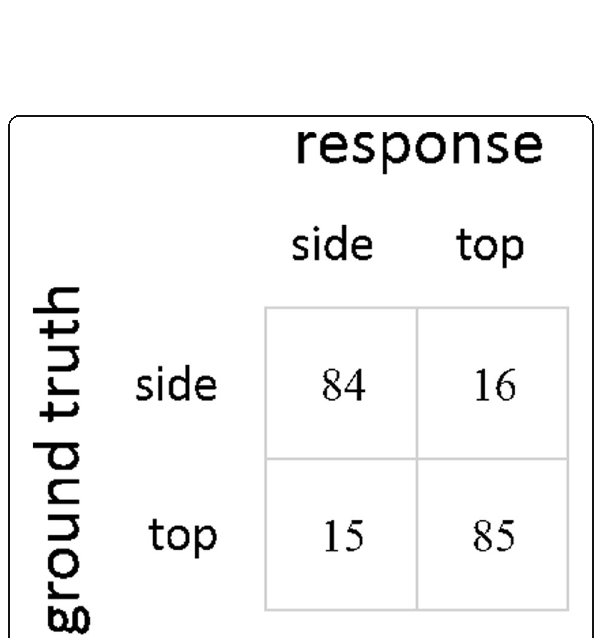
Fig. 9 Results of menu-localization task, in percent of responses. Diagonal values indicate correct classifications